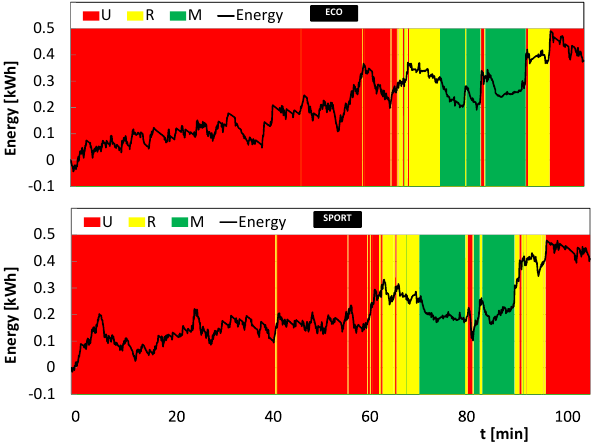
Fig. 9. Energy change during the RDE test by section (urban, rural, high- way) Analysis of Fig. 9 shows that the overall energy flow is positive. The final value for the ECO test is 0.38 kWh, and for the SPORT test 0.40 kWh. The boundaries between test drive sections are also very clear. They occur in the follow- ing order: urban, rural, highway, rural and then urban again (with small interruptions in the sections